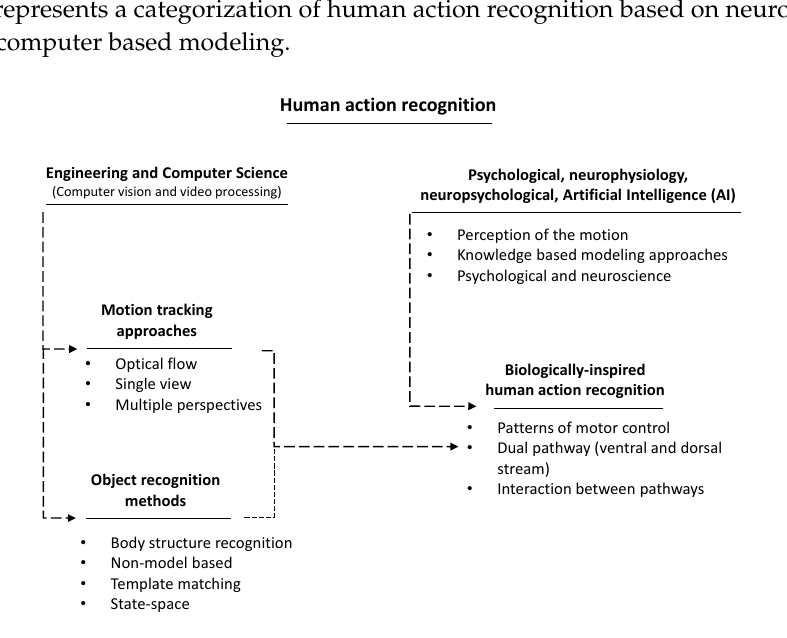
Figure 1. A categorization of human action recognition methods in different methodological